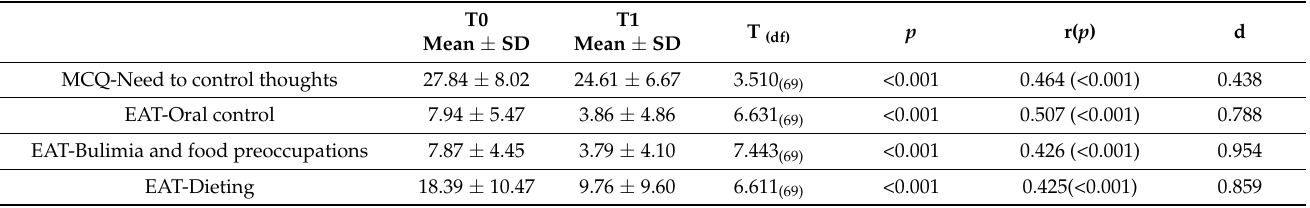
Table 1. Paired t -test for changes in MCQ and EAT subscale scores between baseline and end of treatment. T0 T1 T (df) p r( p Mean ± SD Mean ± SD